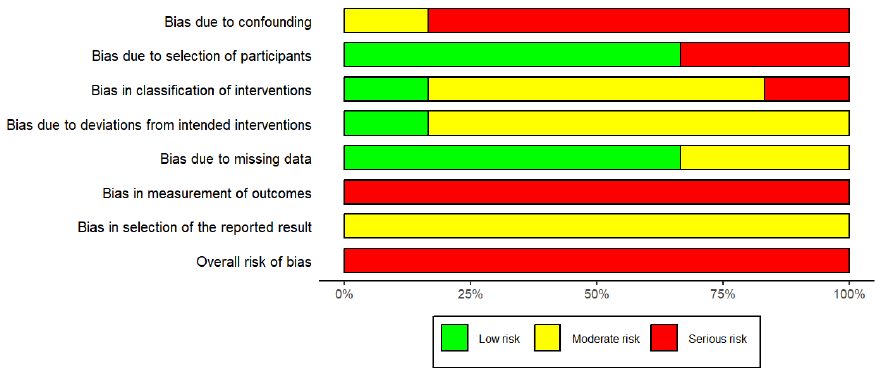
Figure 3. Risk of bias percentage per domain of all included studies assessed with the Risk Of Bias In Non-randomized Studies — of Interventions (ROBINS-I) tool.